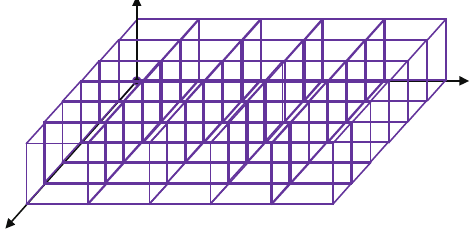
Figure 4. Location area rasterized fill